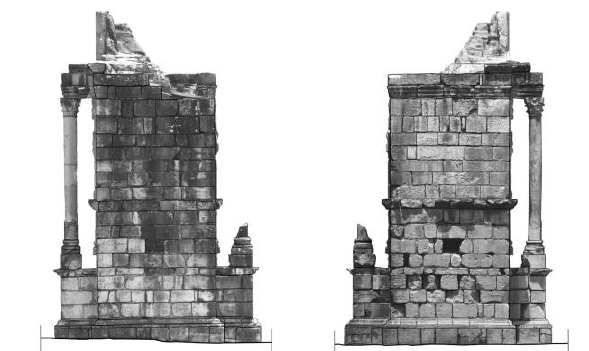
Figure 10. Orthophoto of the north (a) and south (b) elevations (from the 2017